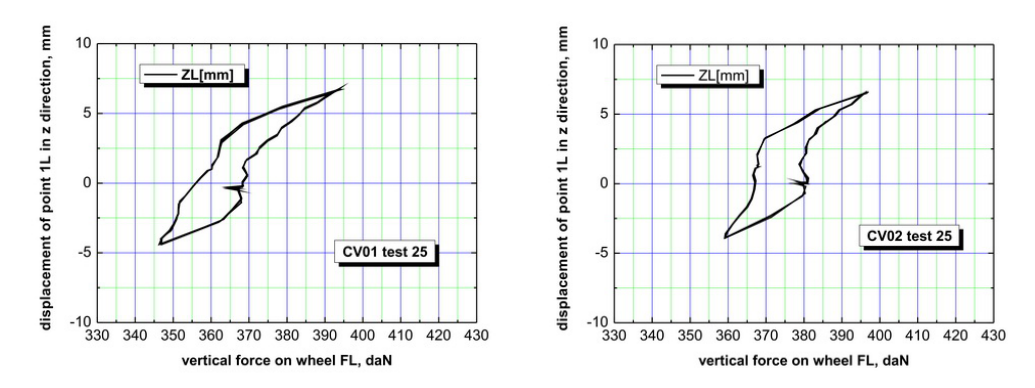
Fig. 5.2. Displacement alterations depending on vertical force during test No. 25.